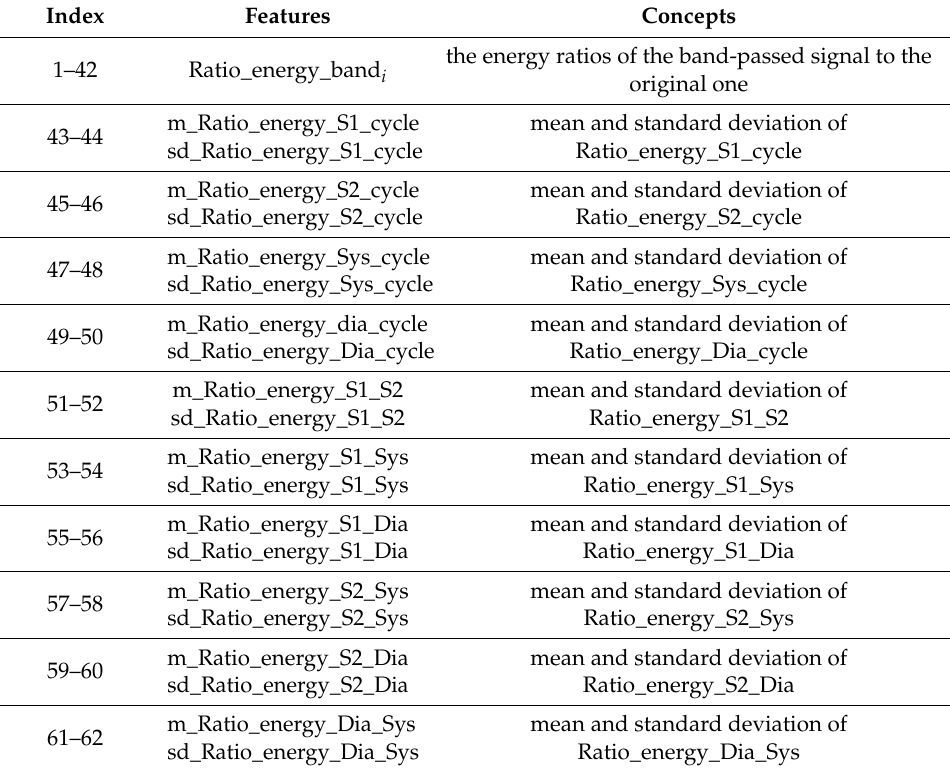
Table A3. The summary of the energy ration features extracted between any two states.